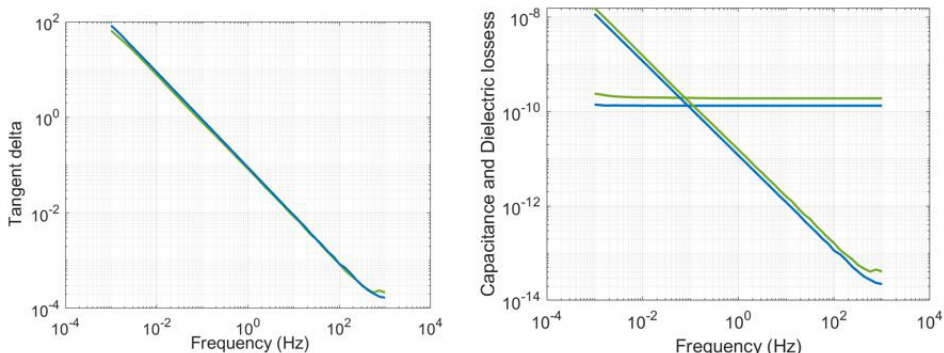
Figure 7. Tangent delta and complex capacitance in the frequency domain of a natural ester (green) and a mineral oil (blue).